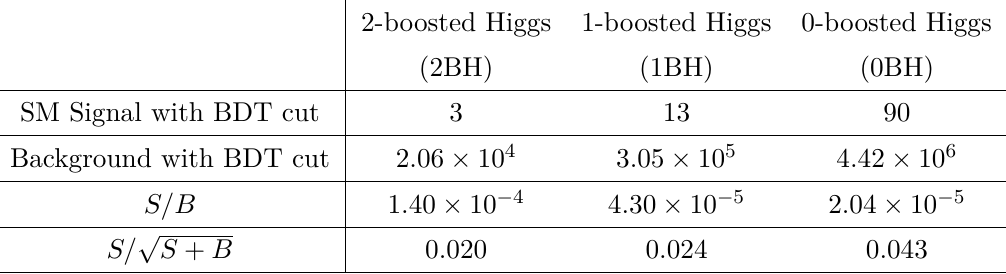
Table 4 . The significances of the BDT at 14 TeV LHC are